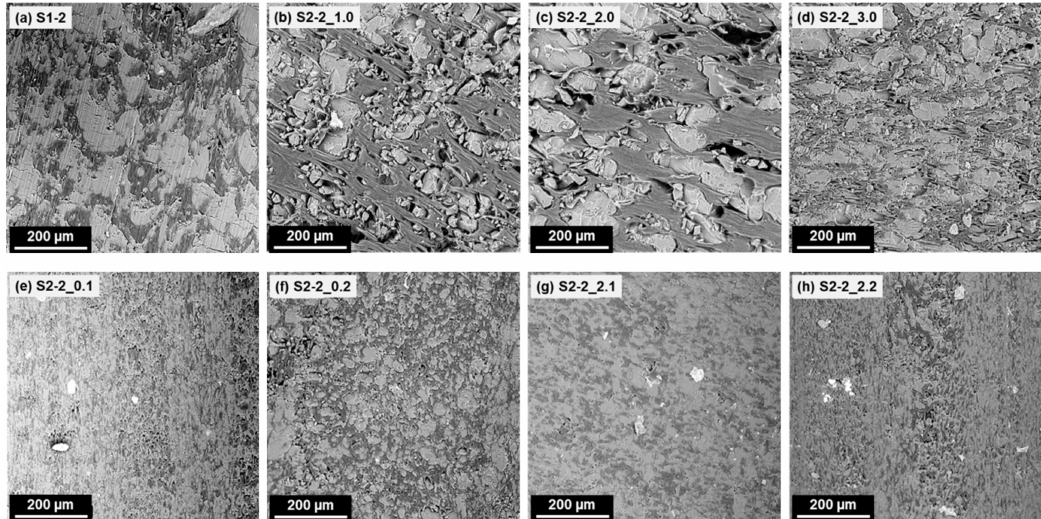
Figure 5. SEM images of the compounds with a 70:30 (novolac + HMTA)–LDPE ratio and different amounts of additives. Bright areas—novolac-based phase; dark areas—LDPE. Mowital and Naftosafe cannotbedistinctlyidentifiedintheSEMimages. Toprow: samplescontaining0m% / 2.5m% / 5m% / 10m% Mowital and no Naftosafe; Bottom row: samples containing no Mowital and 3 m% / 6 m% Naftosafe, and samples containing 5 m% Mowital and 3 m% / 6 m%